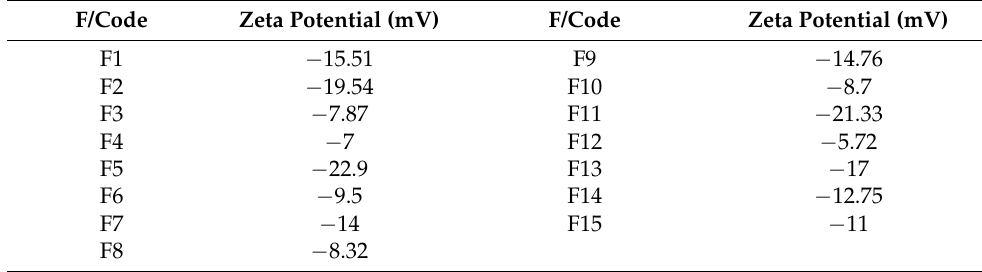
Table 10. Zeta potential of the formulations.